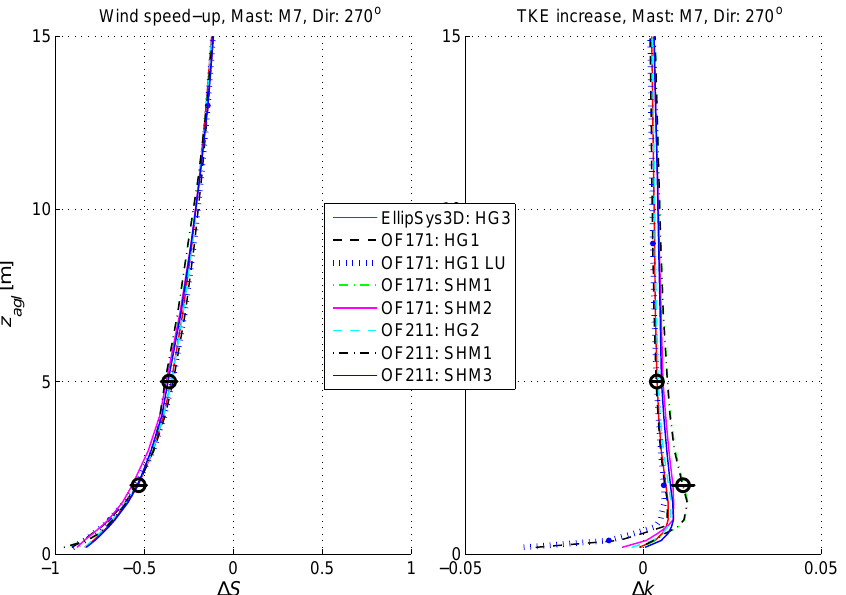
Figure 11. Bolund Hill: mast position 7, speedup and turbulent kinetic energy.